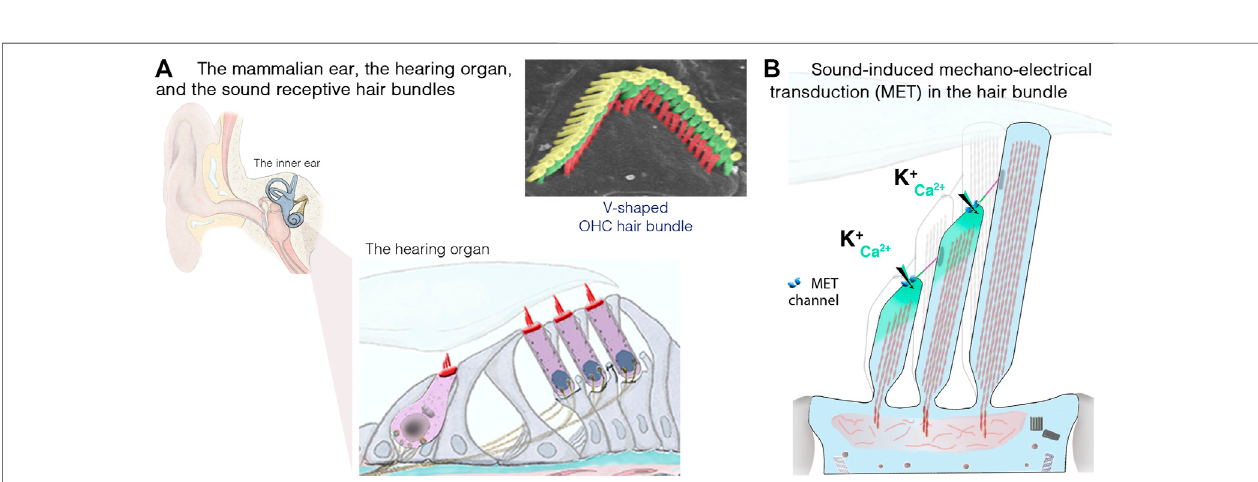
FIGURE3| The inner ear,thehair cellsand thesound-sensitivehairbundles. (A) Themammaliancoiled, snail-shaped cochleahouses theauditory sensoryorgan, also called organ of Corti. Our hearing relies on two types of hair cells: a single row of inner hair cells (IHCs), the genuine sensory cells that transmit sound-induced electrical signals to the brain, and three rows of outer hair cells (OHCs), responsible for sound ampli fi cation. The scanning electron micrograph illustrate the highly organizedstructureofanOHChairbundle,withthreerowsofstereociliaarrangedinastaircasepattern. (B) Schematicrepresentationofthemechanosensitivehair bundle,composedof50 – 100F-actin- fi lledmicrovillusstructures,thestereocilia,arrangedinstaircasepatternattheapicalhaircellsurface.Incomingsoundwavestothe cochlea ultimately lead to the de fl ection of the hair bundle. Positive de fl ection, in the direction of the longest stereocilium, triggers the opening of the mechano-electrical transduction (MET) channels; located at the lower end of an extracellular fi brous link, the tip link. The ensuing in fl ux of Ca 2+ and K + ions leads to hair-cell depolarization, resultinginmembranepotentialchangesleadingtogradedmodulationofglutamatereleaseattheIHCsynapticactivezones,whichconveysignalinformationtothebrain through the auditory primary neurons (adapted from Dulon et al., 2018; Delmaghani and El-Amraoui, 2020).